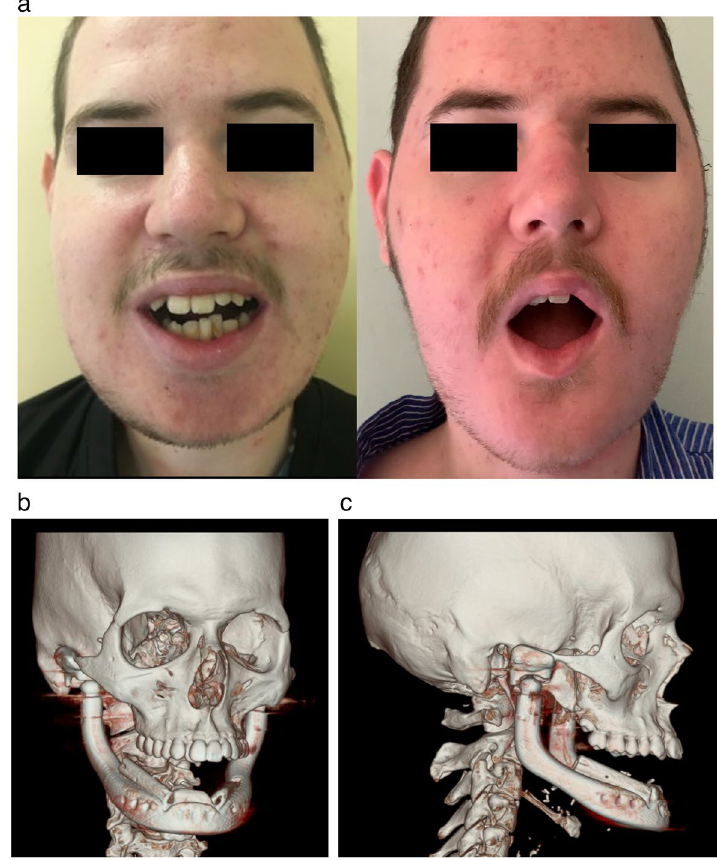
Fig. 5 a Early outcomes, at 12-months follow-up. In frontal view, note the mouth opening and the facial symmetry restoration. b , c the post-operative 3DCT scan